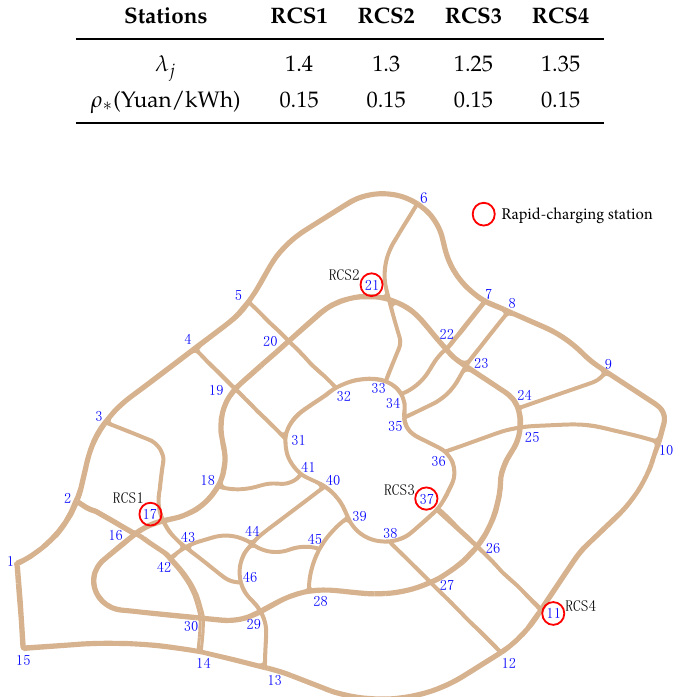
Figure 6. Transportation network and its topological graph based on Guangzhou Higher Education Mega Center.